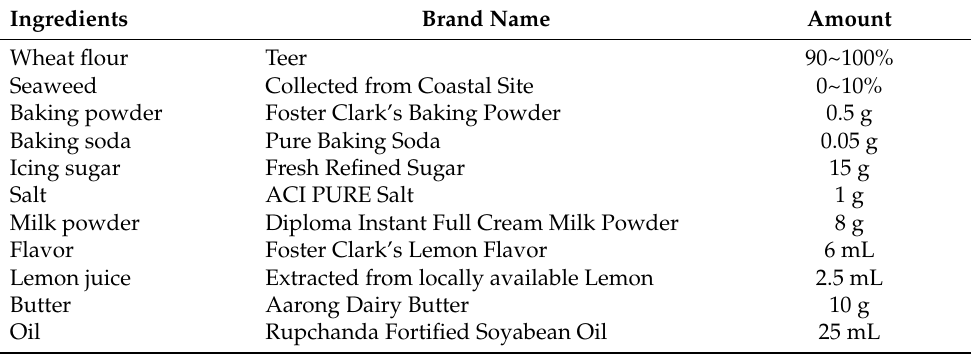
Table 1. Ingredients of UI seaweed-based